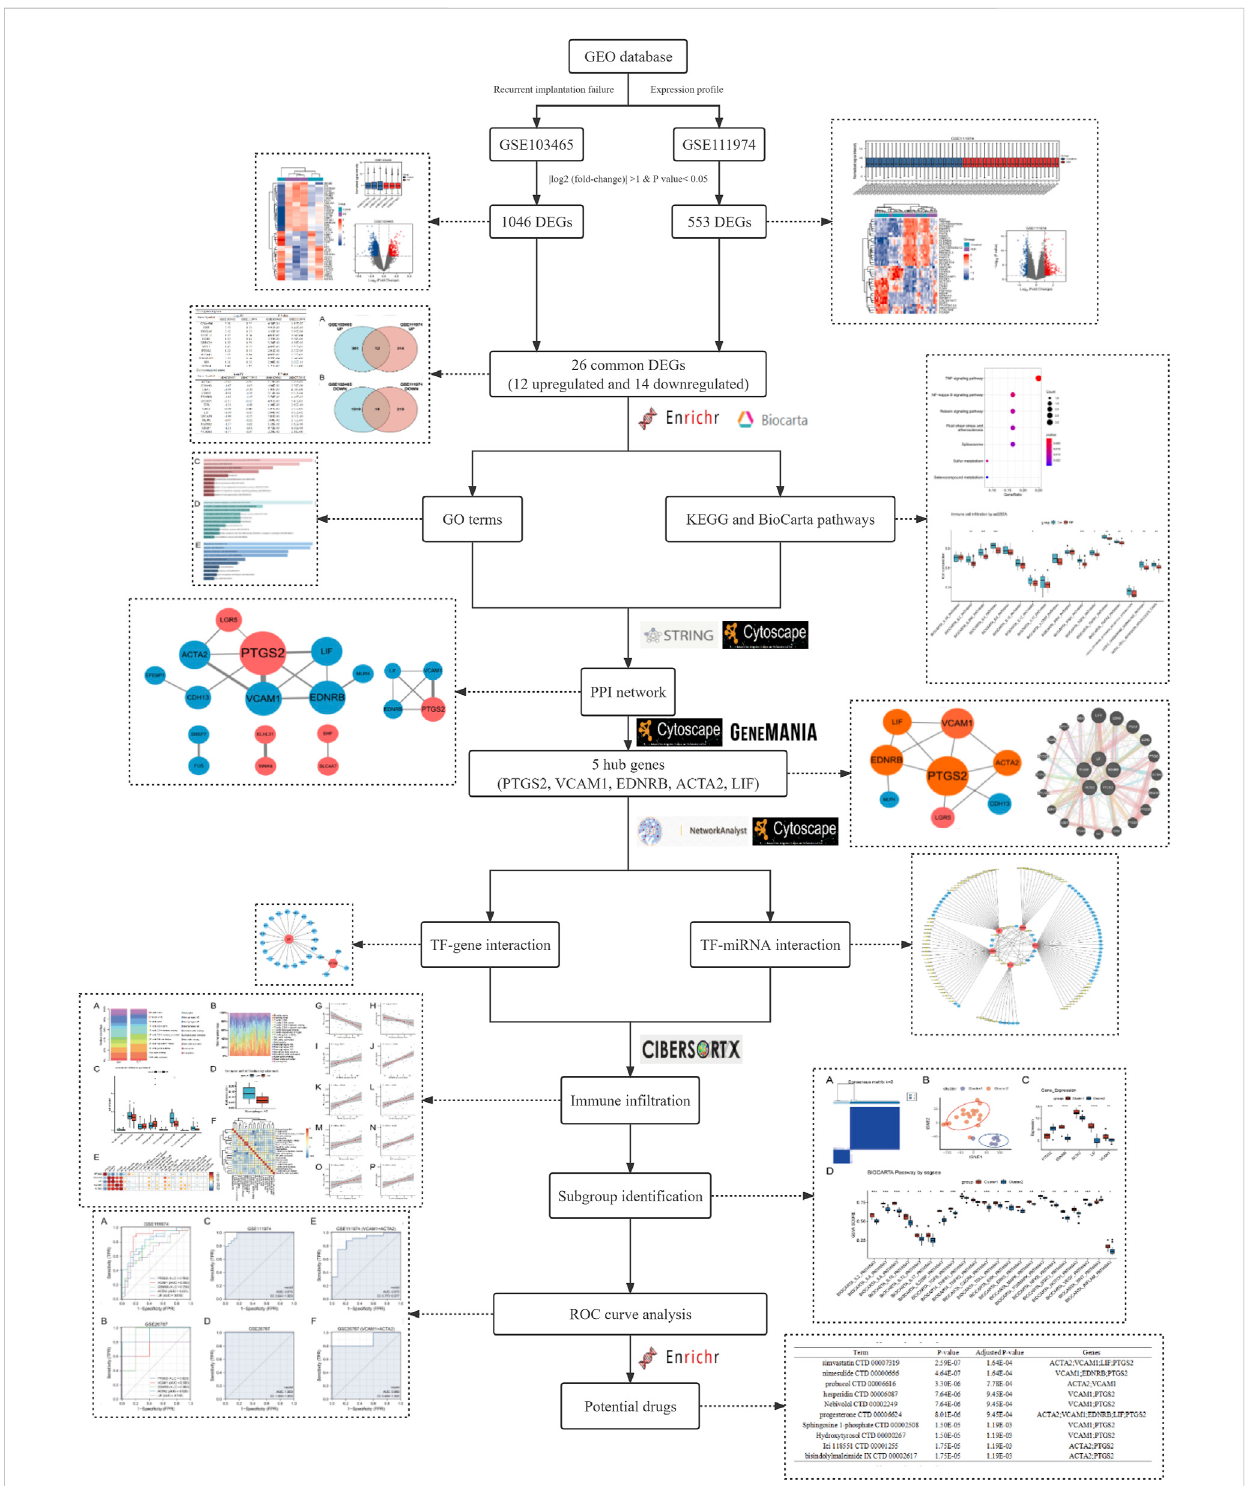
FIGURE 1 Methodical work fl ow for the current